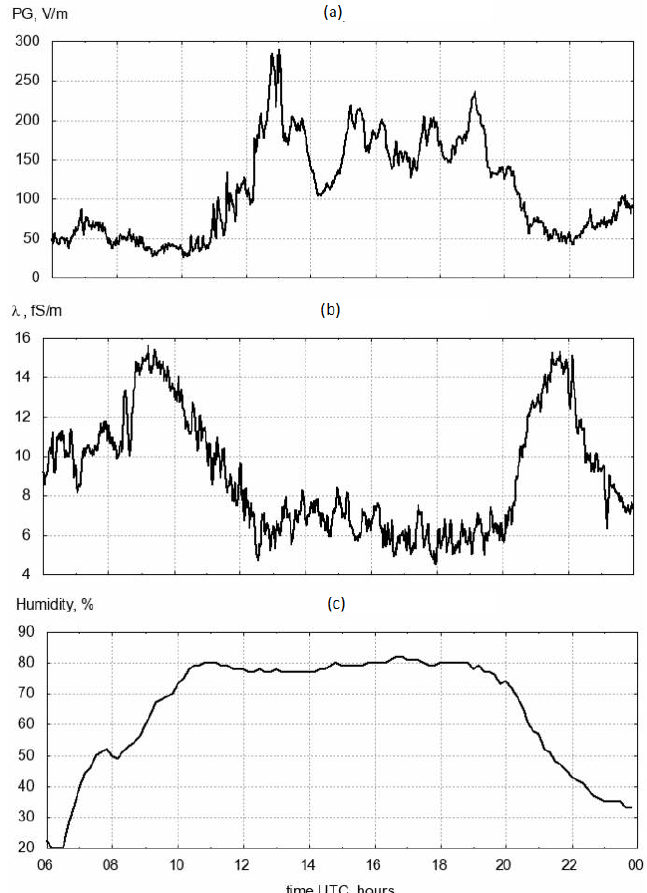
Figure 7. Fog effect for 31 May 2010: ( a ) PG values; ( b ) electrical conductivity of air; ( c ) air